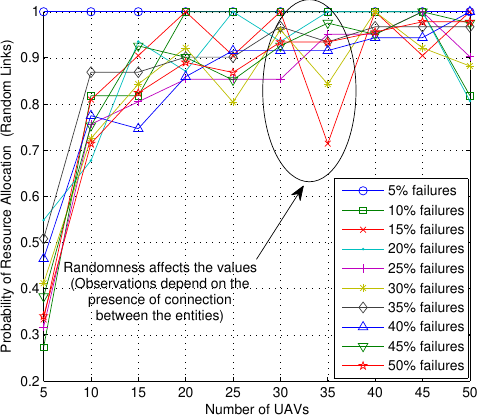
Figure 11. Probability of resource allocation with random link deployment vs. number of UAVs.